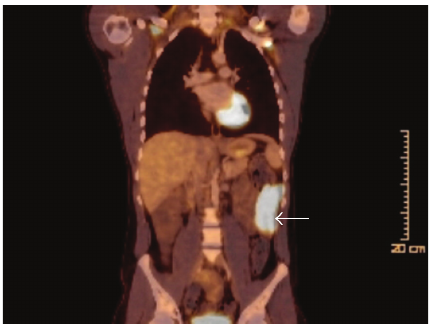
Figure 4: PET scan shows FDG avid small bowel segment with circumferential thickening (arrow) with no evidence of distant